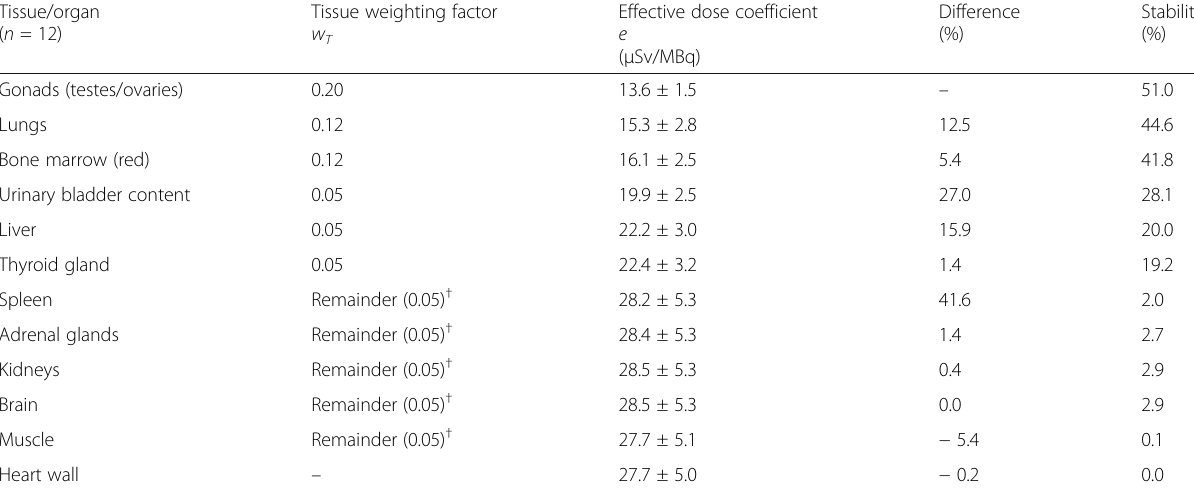
Table 7 Impact of number of tissues/organs for CE stylized reference phantoms depending on decreasing ICRP Publication 60 tissue weighting factors w T to calculate the effective dose coefficient, e , with the SD. The difference in percent calculated according to Eq. 4 and stability according to Eq.